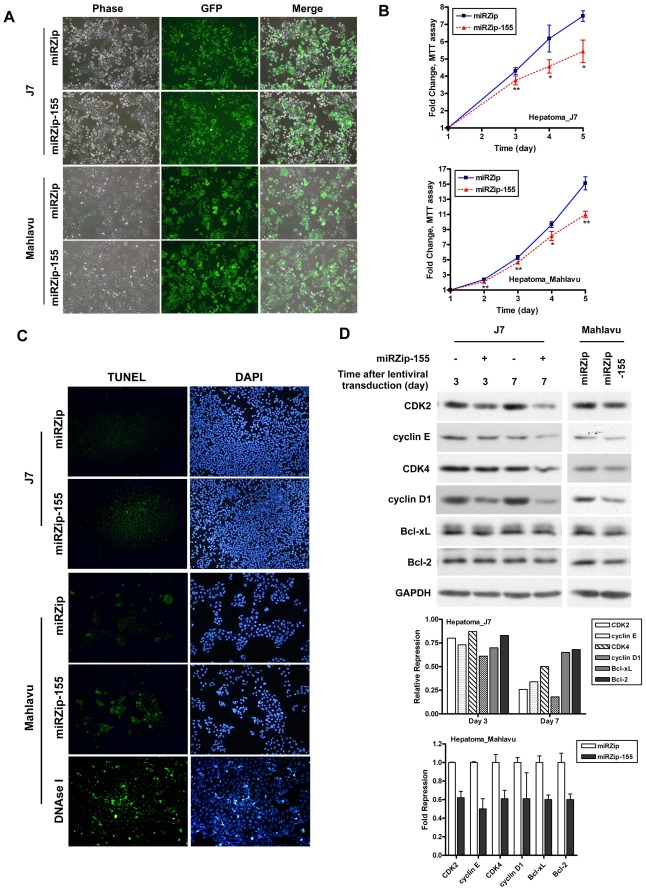
Reduced cell viability by expression knockdown of miR-155 in hepatoma cells.(A) GFP expression in J7 and Mahlavu cells transduced with lentivirus carrying miRZip and miRZip-155 vectors, respectively. GFP, an expression marker encoded by the miRZip vector. (B) Comparisons of the cell proliferation rates assessed by MTT assays between hepatoma cells (J7 [upper panel] and Mahlavu [lower panel]) with (miRZip-155, red triangles) or without (miRZip, blue squares) expression knockdown. *P<.05; **P<.01. (C) Comparisons of cell apoptosis assessed by TUNEL assays between hepatoma cells (J7 [upper panels] and Mahlavu [lower panels]) with (miRZip-155) or without (miRZip) expression knockdown. Cells treated with DNAse I served as a positive control for the TUNEL assay (bottom panel). (D) Immunoblot analysis examined the expression levels of CDK2, cyclin E, CDK4, cyclin D1, Bcl-xL, and Bcl-2 in lentivirus transduced J7 and Mahlavu cells. GAPDH served as a loading control. Quantitative data (by densitometer) were shown in the bottom.